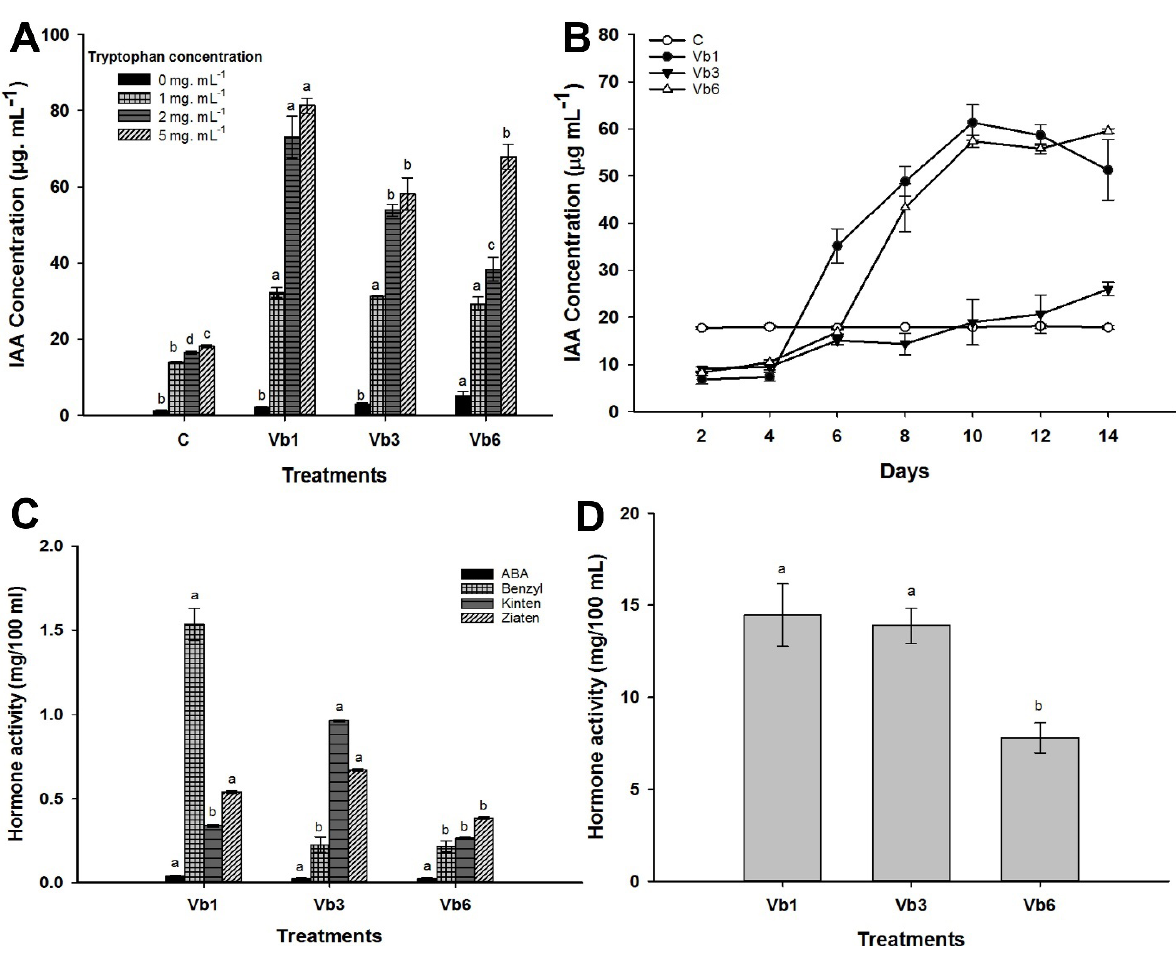
Figure 4: Phytohormones production by three rhizospheric bacterial species Vb1, Vb3, and Vb6. A) denote the qualitative production of IAA at different concentrations of tryptophan (0, 1, 2, and 5 mg ml -1 ); B) denote the quantitative production of IAA at different interval times in presence of 5 mg ml -1 tryptophan, C) denote the production of ABA, Benzyl, Kinten, and Ziaten phytohormones detected by HPLC analysis, D) denote the production of GA detected by HPLC. Bars with the different letters are significantly different ( p ≤ 0.05). Error bars indicate means 3 ± SE ( n =